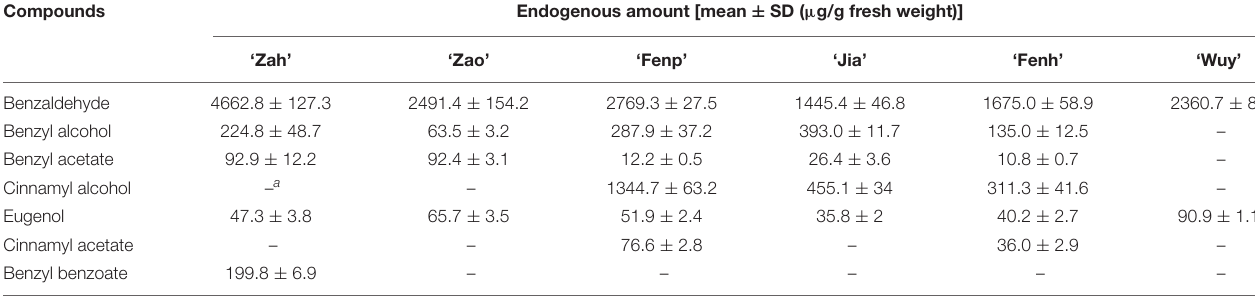
TABLE 1 | Endogenous amount of main floral scent compounds in the six Prunus mume cultivars.